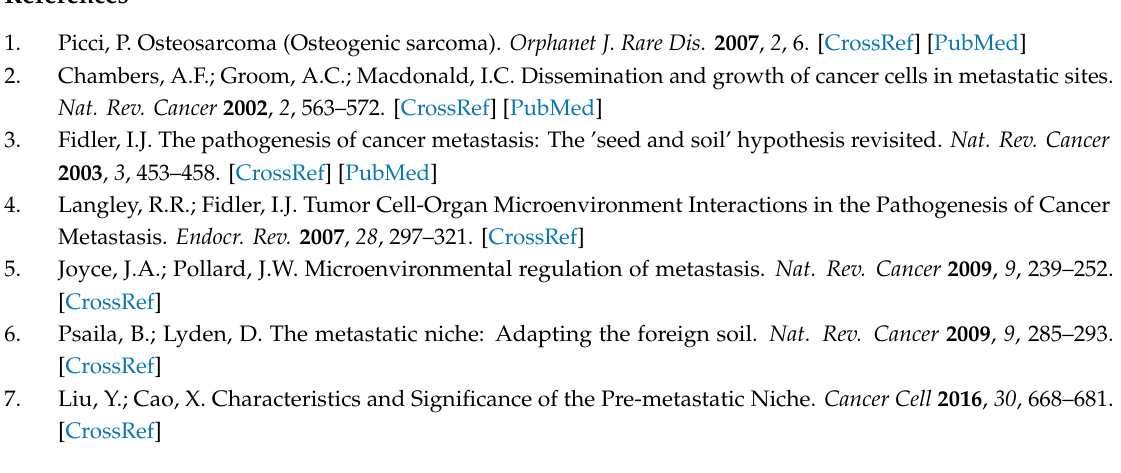
Figure S1: X-Gal staining of mouse lungs 4 h and 4 days after orthotopic implantation of 143-B tumor cells. Figure S2: Transcriptomic profiling of pre-metastatic lungs. Figure S3: CD11b + and Gr-1 expression in mouse lung sections. Figure S4: EV characterization. Table S1: RNA-seq data analysis of di ff erentially expressed genes comparing the lungs of tumor-bearing mice versus control mice. Table S2: Top 250 upregulated genes in the pre-metastatic